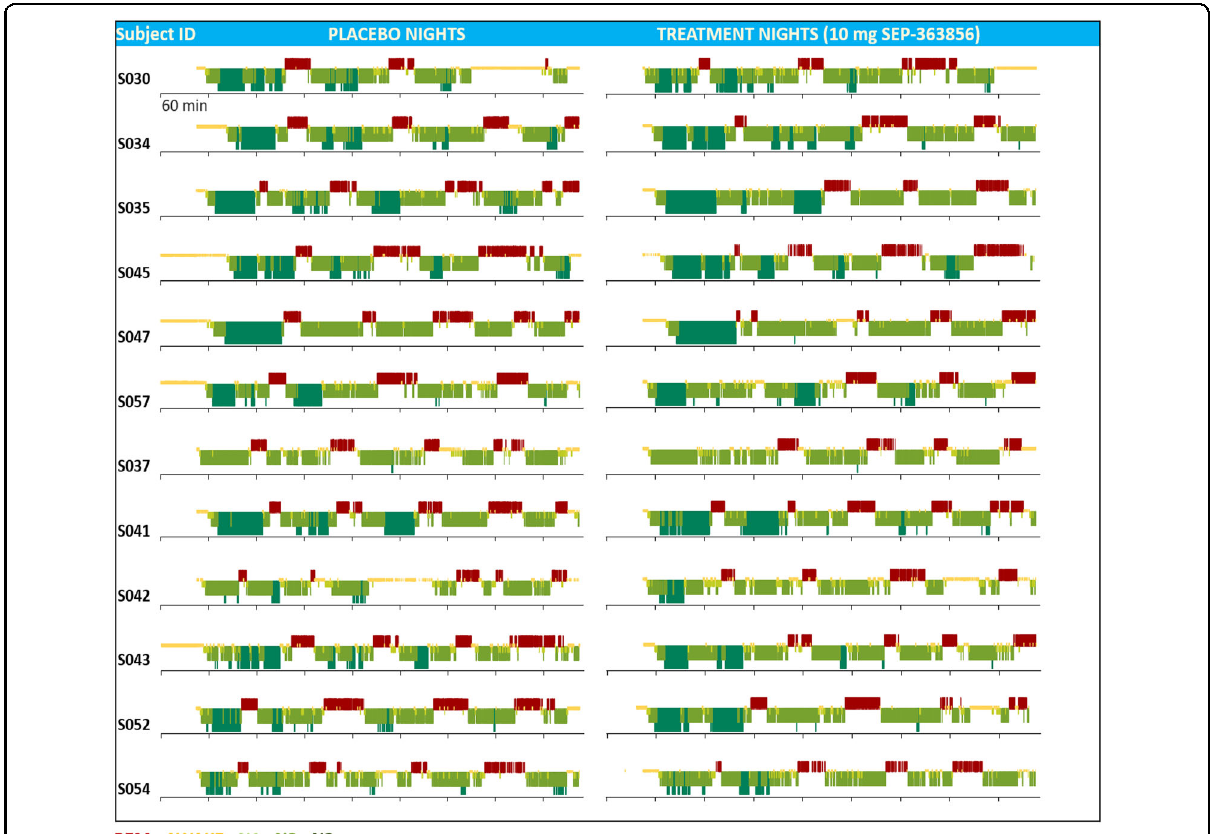
Fig. 4 Individual hypnograms from all 12 subjects following crossover treatment with 10 mg SEP-363856 or placebo. SEP-363856 increased the latency to REM sleep in most